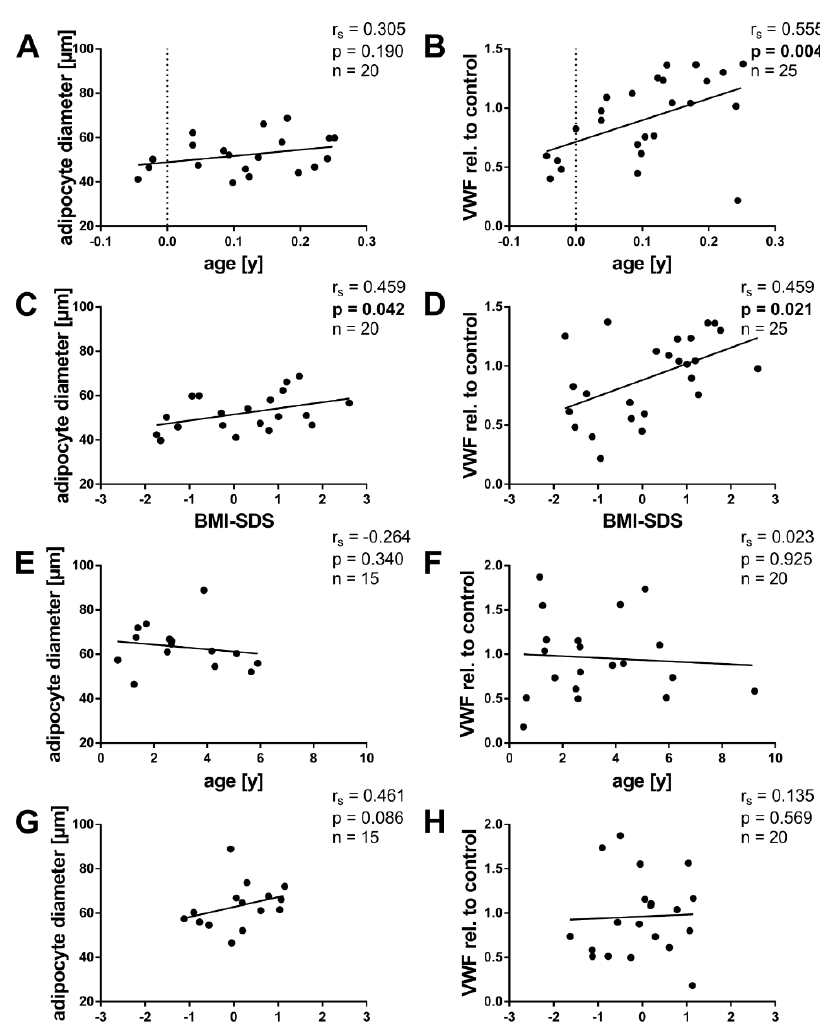
Figure A1. Association of adipocyte diameter and VWF expression with age and BMI-SDS in the WAT of infants < 6 and children ≥ 6 months. Adipocyte size was determined in histologic sections as specified in Methods. Total RNA was isolated, reverse transcribed, and subjected to qPCR analysis using a specific primer pair as indicated. VWF gene expression was calculated as described in Methods and plotted against age. ( A ) In contrast to the analysis with all children, adipocyte size did not correlate positively with age in the infants < 6 months. ( C ) Adipocyte size did, in turn, correlated positively with BMI-SDS. ( B , D ) VWF correlated positively with age and BMI-SDS in the infants < 6 months. ( E – F ) There were no significant correlations of adipocyte diameter and VWF with age or BMI-SDS in the children ≥ 6 months. Spearman correlation coe ffi cient r s and p value, as well as number of subjects, are given in each scatter plot. Significant p values ( p < 0.05) are indicated in bold. Trend lines were calculated as linear